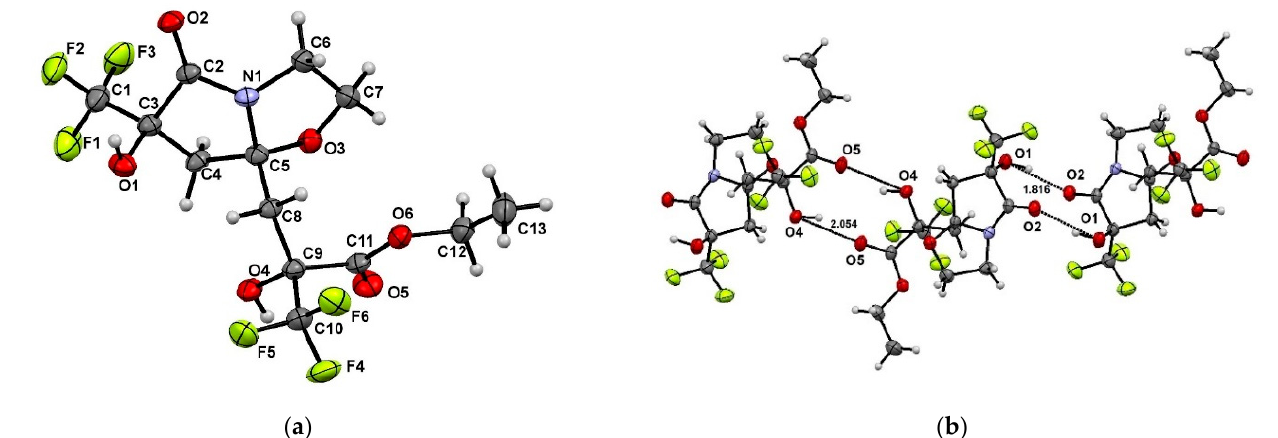
Figure 4. ( a ) The ORTEP view of compounds 5 tc according to XRD data; ( b ) crystal packing of compounds 5 tc with indication of intermolecular hydrogen bonds.